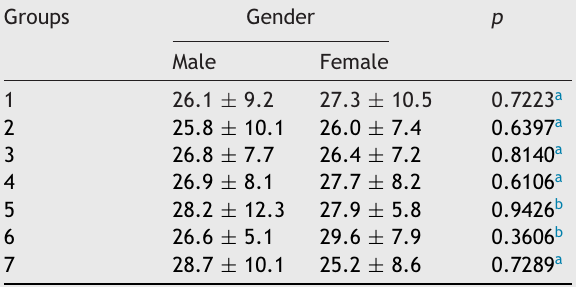
Distribution, in mean values ± standard deviation, of the age range in each group analyzed in relation to gender.